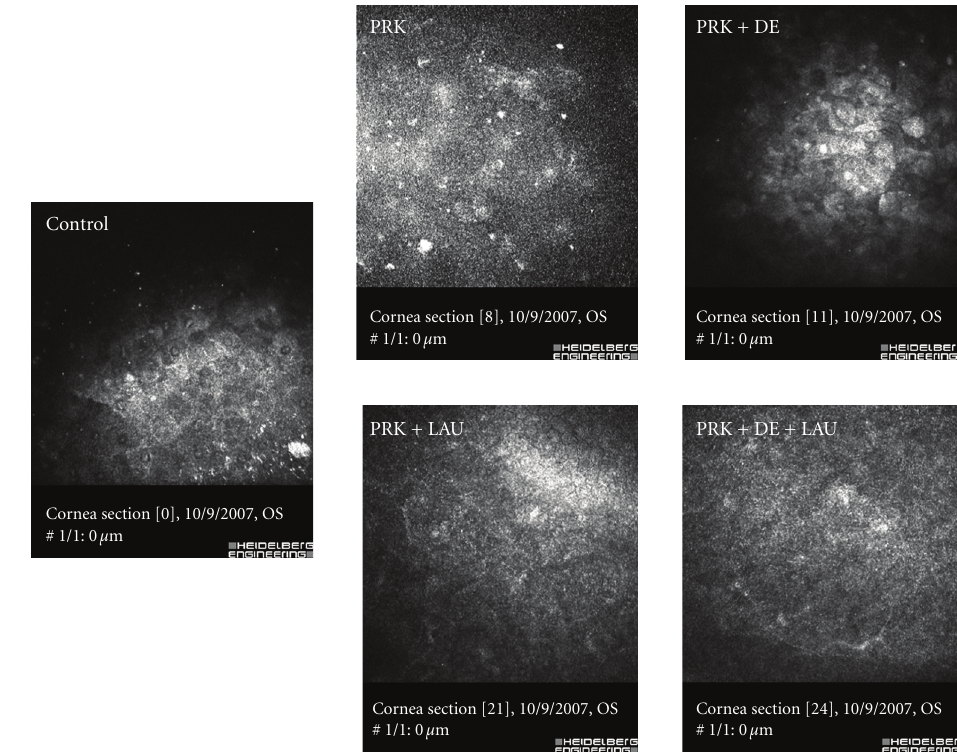
Figure 1: In vivo confocal microscopy images of corneal epithelium in mice after PRK and exposure to desiccating environment with and without treatment with LAU-0901. Increased number of reflective structures was observed in the corneal epithelium after PRK and exposure to DE in eyes treated with vehicle as compared with eyes treated with LAU-0901 (743 ± 128 cells/mm 2 versus 421 ± 109 cells/mm 2 ). The increase in the number of reflective bodies was more significant in the vehicle group compared with LAU-0901 treated